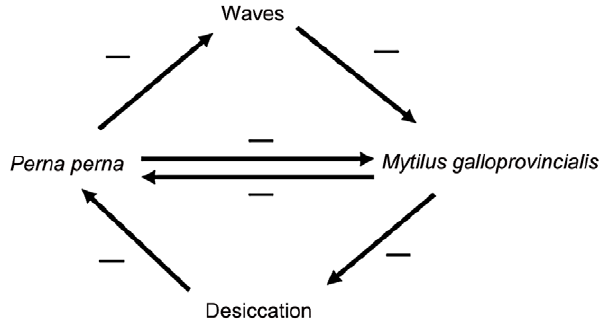
Figure 4. Summary of suggested explanations of how two negative effects interact to produce a positive effect. The amelioration of abiotic stresses by the more tolerant species constitutes an indirect positive effect (two negative effects making a positive one) on the less tolerant competitor. In the case of wave action, this is an indirect effect of P. perna on M. galloprovincialis . In the case of desiccation stress, the reverse is true. Direct interactions between the two are